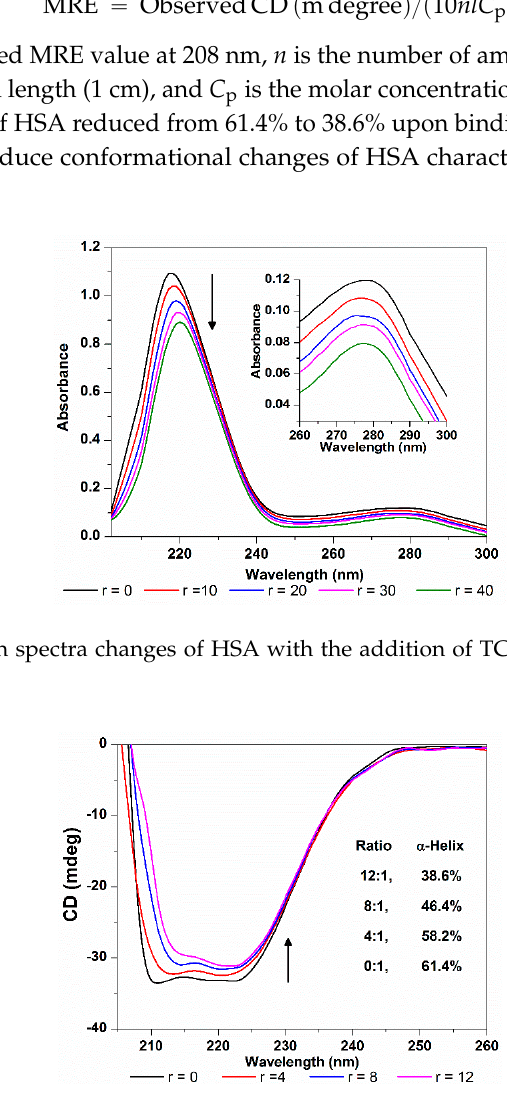
Figure 12. CD spectra changes of HSA with the addition of TCPC ( r = [TCPC]/[HSA]) in Buffer IV (pH = 7.4).